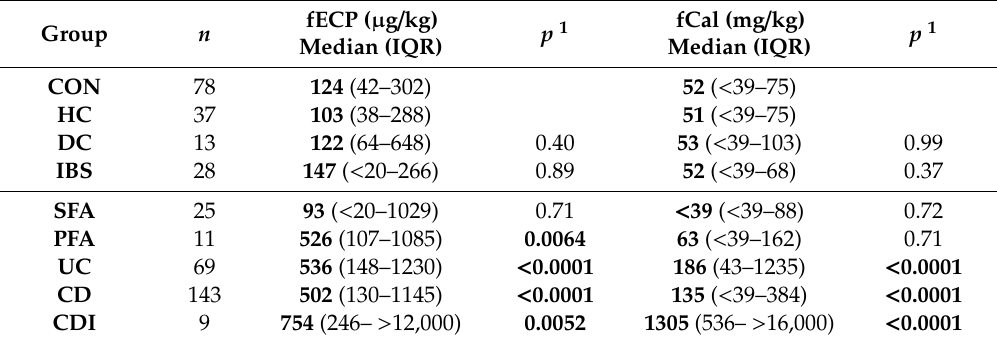
Table 3. Fecal eosinophil cationic protein (ECP) ( µ g / kg) and calprotectin (mg / kg) in di ff erent patient